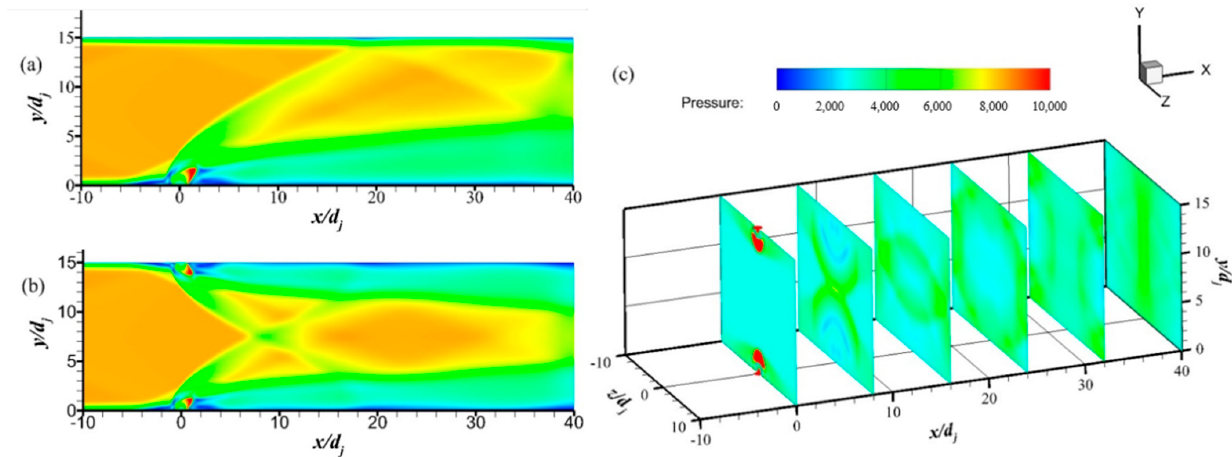
Figure 6. Comparison of the contours. ( a ) Case1 the Mach number contour. ( b ) Case2 the Mach number contour. ( c ) Case2 pressure contours.